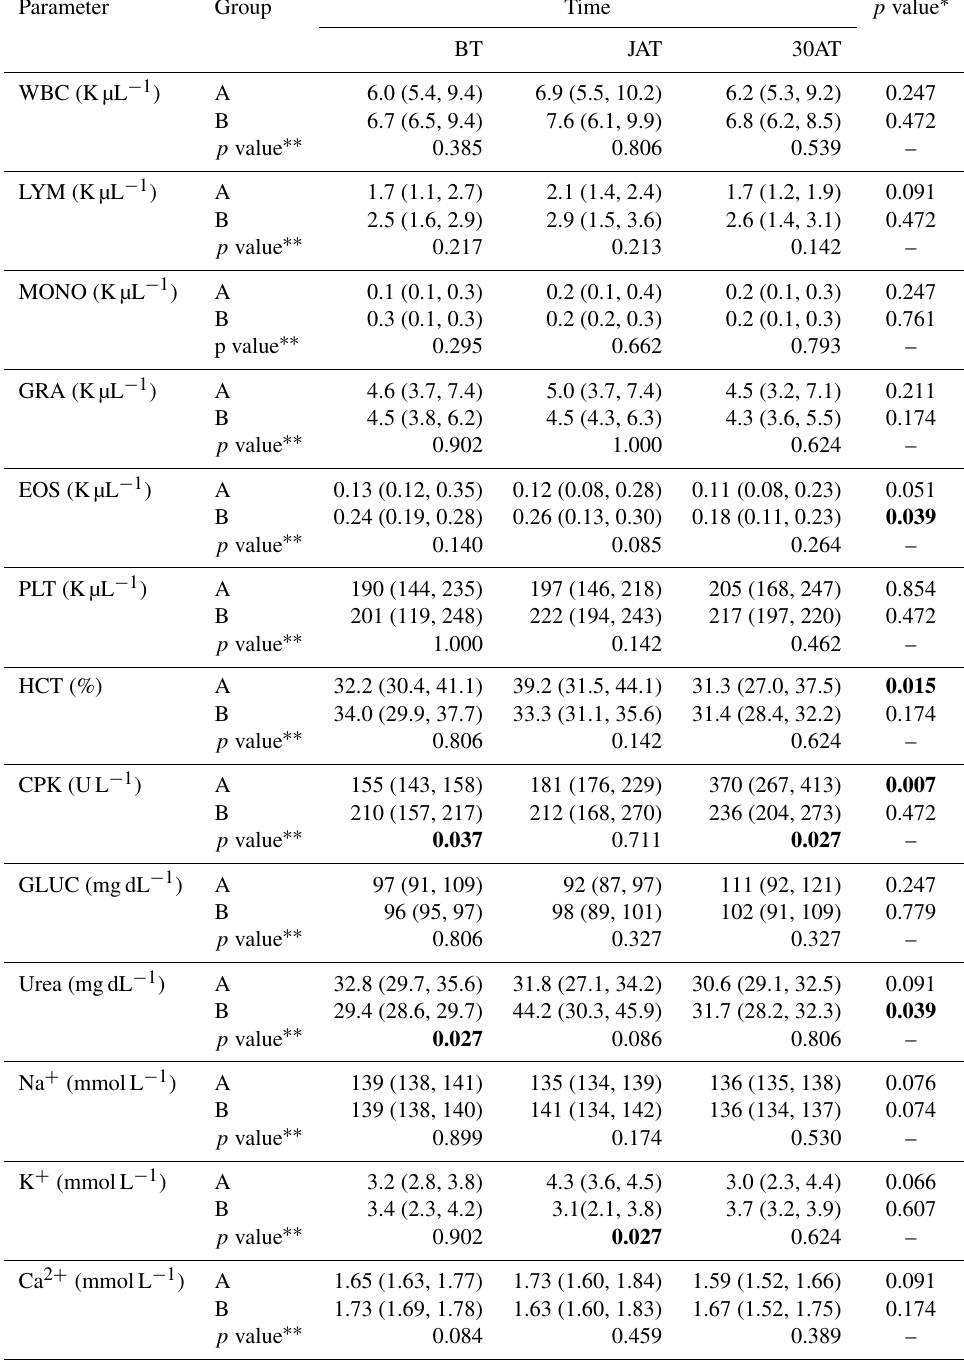
Table 2. Median (min, max) blood test results before the training on the treadmill (BT), just after the training (JAT) and 30min after the training (30AT) and the results of the non-parametric significance